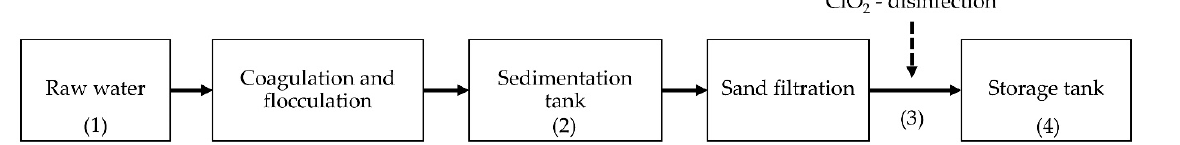
Figure 2. Sampling locations in the water supply system.